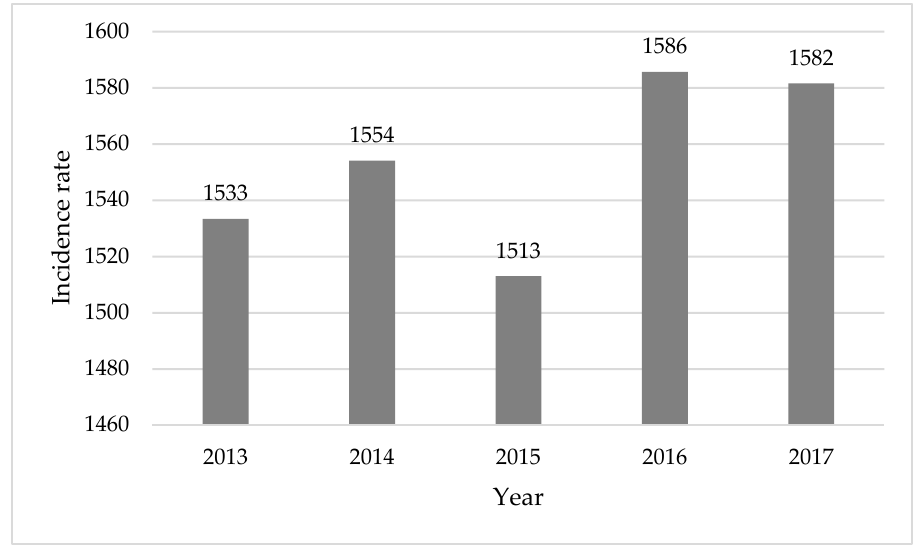
Figure 5. Incidence rate for non-fatal accidents [1,2].